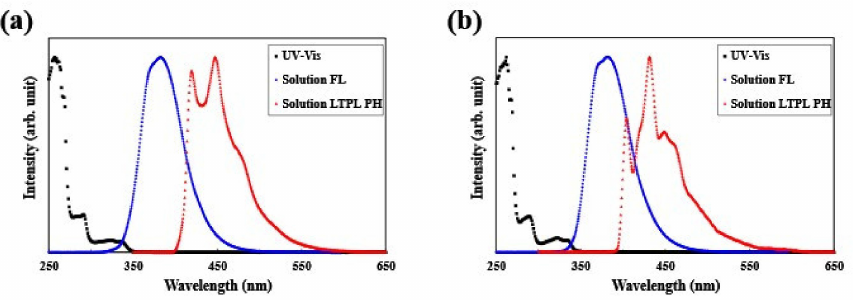
Figure 2. UV-Vis absorption spectra, fluorescent spectra (FL) and phosphorescent spectra (PH) of ( a ) 26CzDBF in solution and ( b ) 46CzDBF in